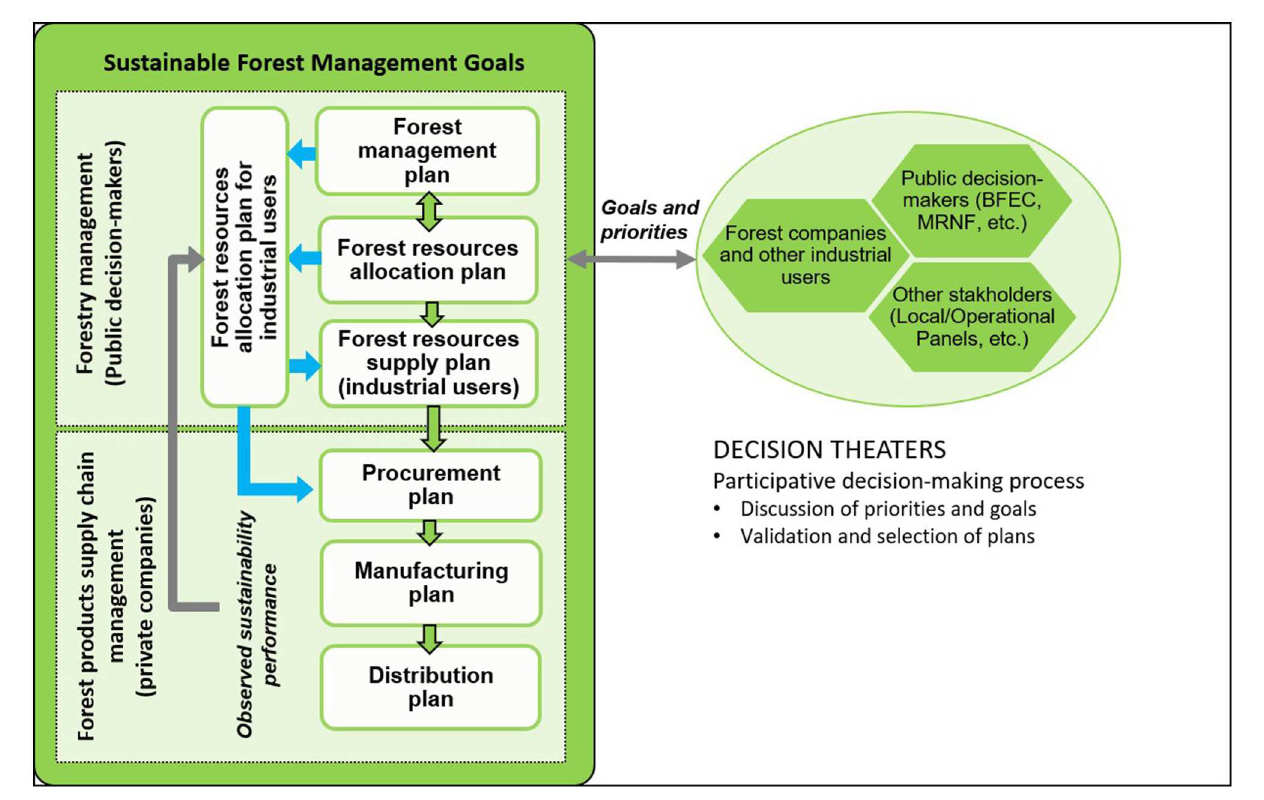
FIGURE2 The proposed model to improve stakeholders’ satisfaction and sustainable objectives integration of Forest management and Forest products supply